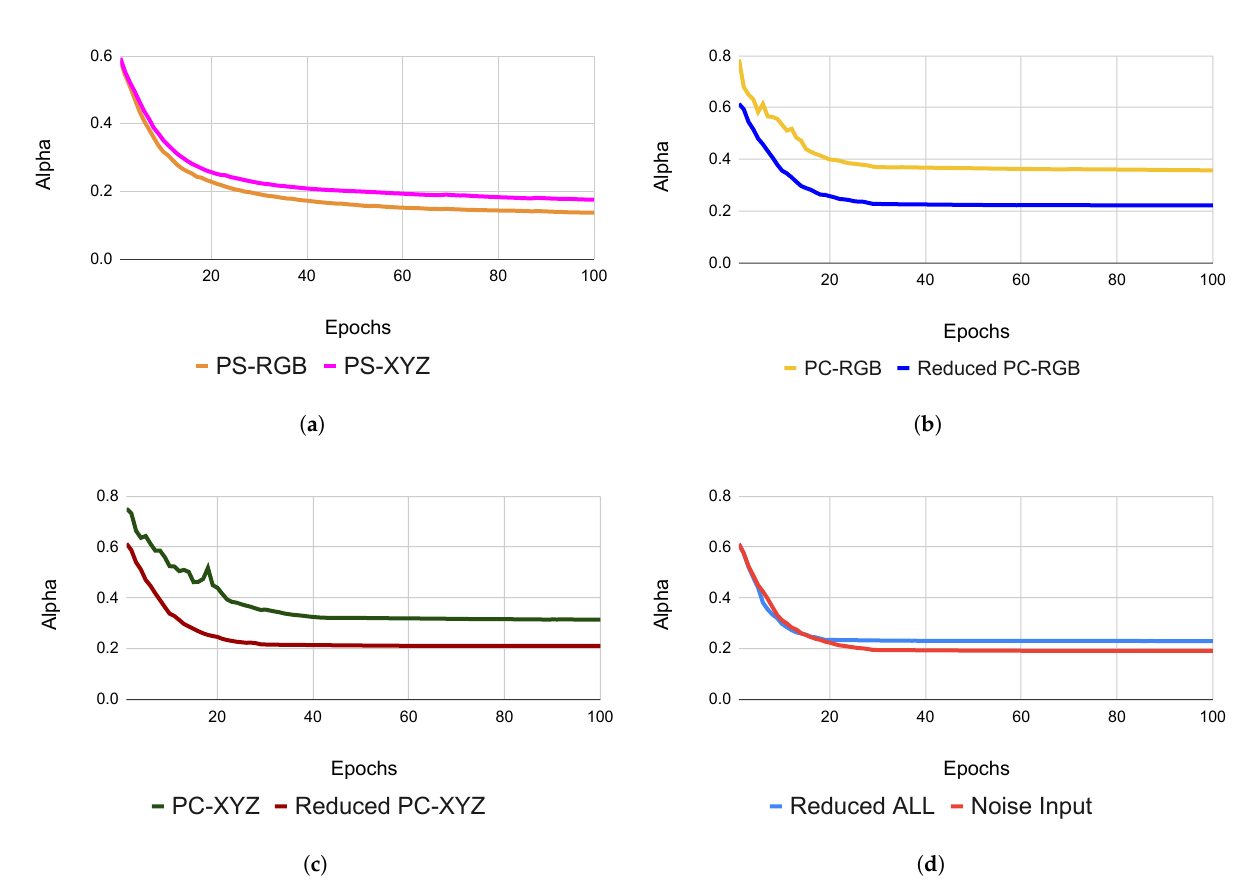
Figure 9. Behaviors of topological rates α in the training process of models with topological assistance. The horizontal axis is the number of training epochs, and the vertical axis is α . ( a ) PS-RGB (dim = 114) and PS-XYZ (dim = 114). ( b ) PC-RGB (dim = 1530) and Reduced PC-RGB (dim = 512). ( c ) PC-XYZ (dim = 1020) and Reduced PC-XYZ (dim = 512). ( d ) Reduced ALL (dim = 512) and random noise (dim =